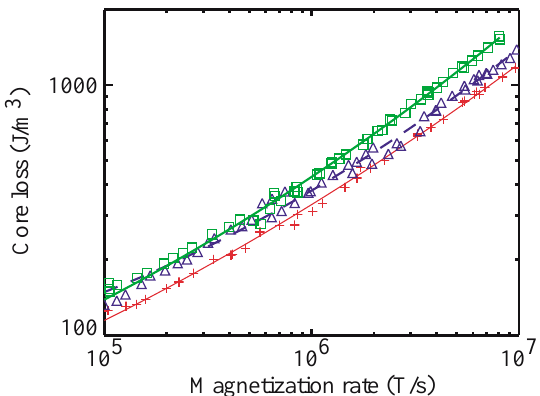
FIG. 15. (Color) Core loss versus magnetization rate for three METGLAS thin-SA1 cores, manufactured by MRTI. The data are for the listed flux swings: ( (cid:1) , green) MRTI Thin-2605 SA1-4 at 2.10 T; ( (cid:3) , blue) MRTI Thin SA1-3 at 2.10 T; and ( 1 , red, solid line) MRTI Thin SA1-2 at 2.10